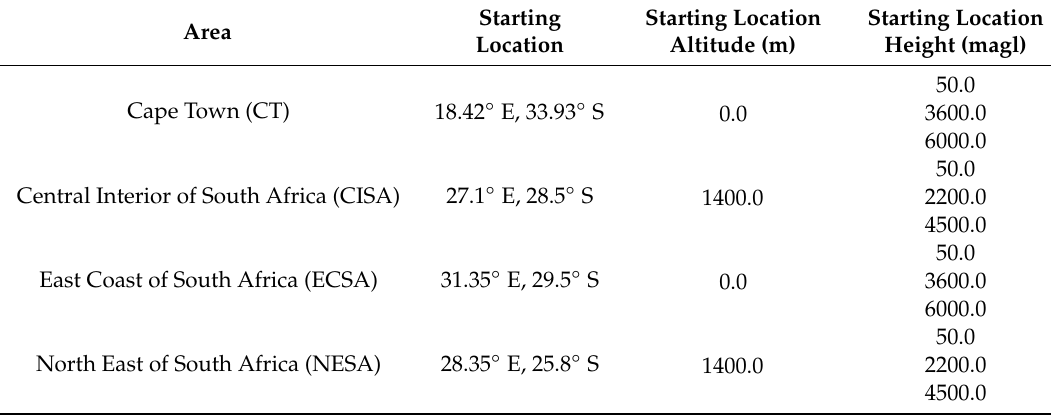
Figure 2. Map of South Africa showing the trajectory starting point positions and demarcations of study areas used for trajectory analysis. Table 2. The study areas and their geographic